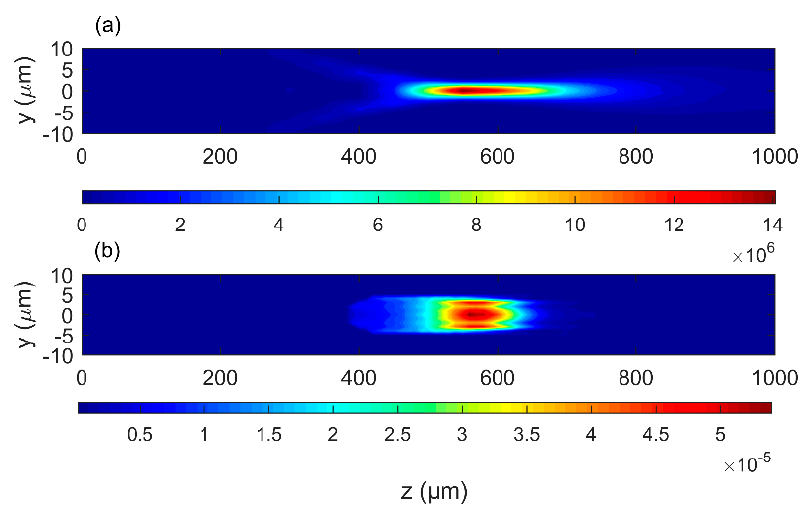
Figure 3. Two-dimensional simulation profile inside a 1 mm × 1 mm PDMS channel. ( a ) Illumination power density profile; ( b ) feedback–power ratio profile.